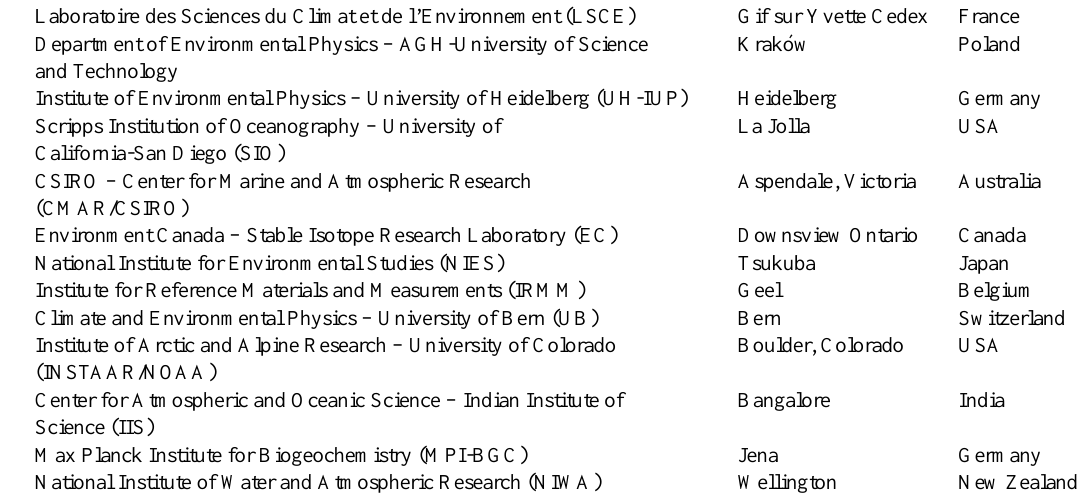
Table 1. Laboratories that participated in the JRAS